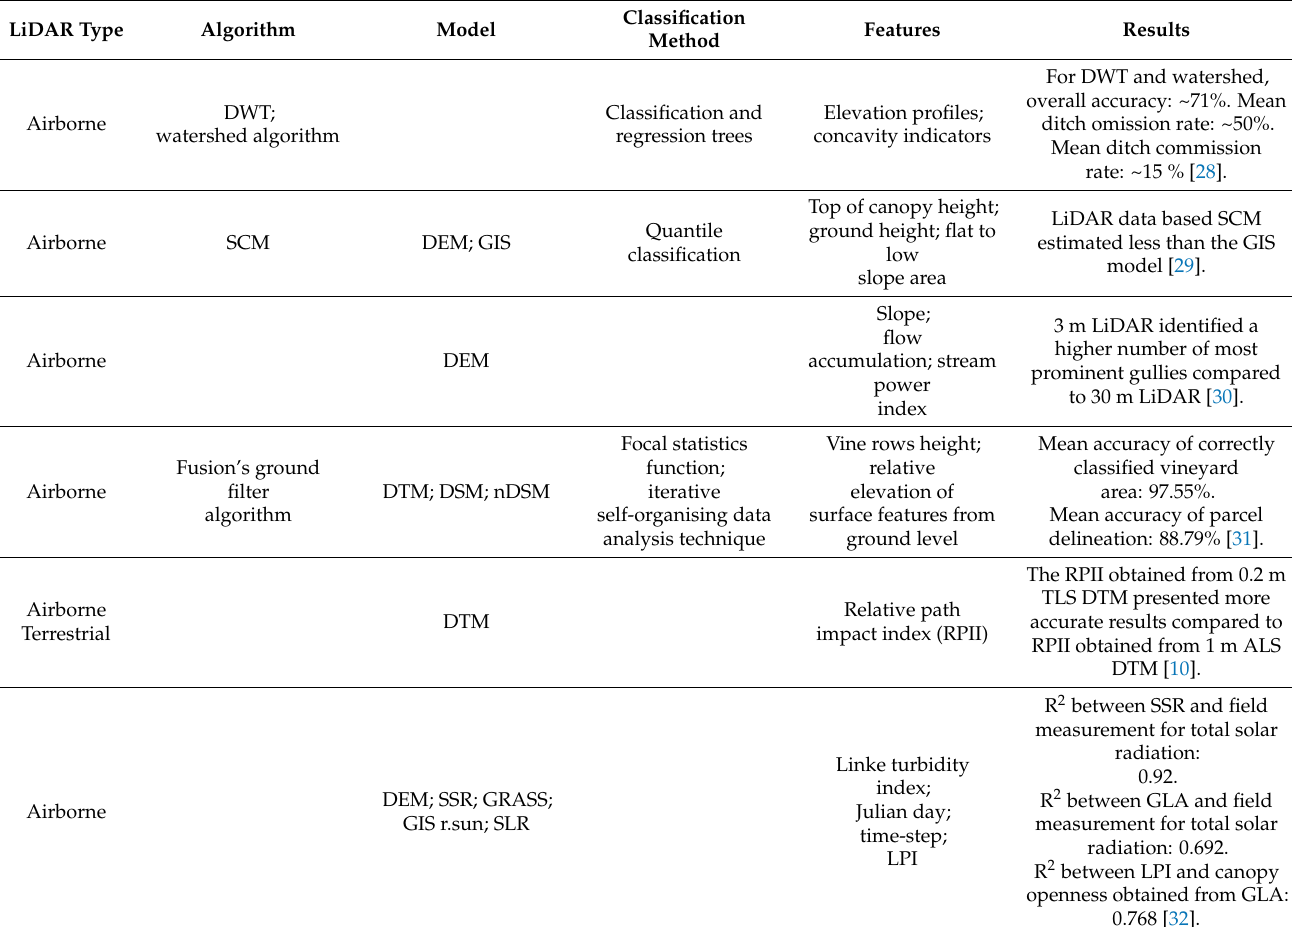
Table 1. Comparison of various aspects of LiDAR data in determining agricultural landscape and